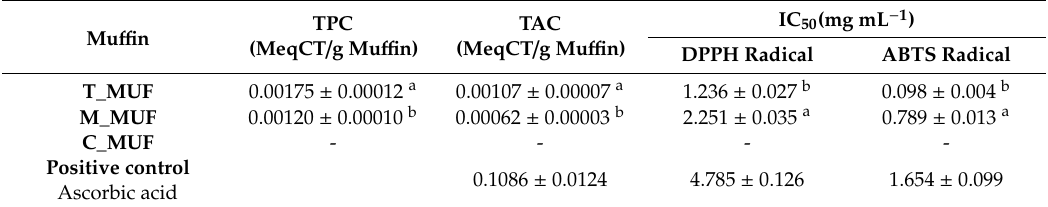
Table 3. Antioxidant properties of the prepared mu ffi ns. Data are presented as mean ± SD ( n = 3), di ff erent letters in the same columns are statistically di ff erent ( p <